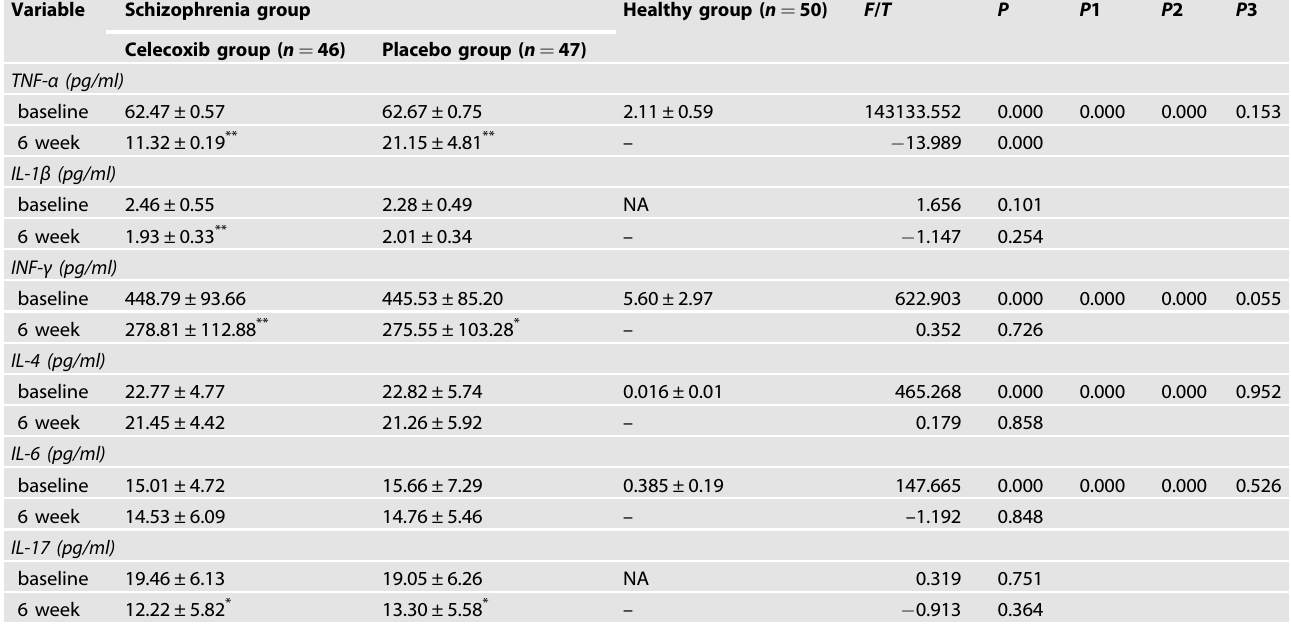
Table 4. Treatment outcome of in fl ammatory cytokines for different subgroups of patients and healthy groups. Variable Schizophrenia group Healthy group ( n =